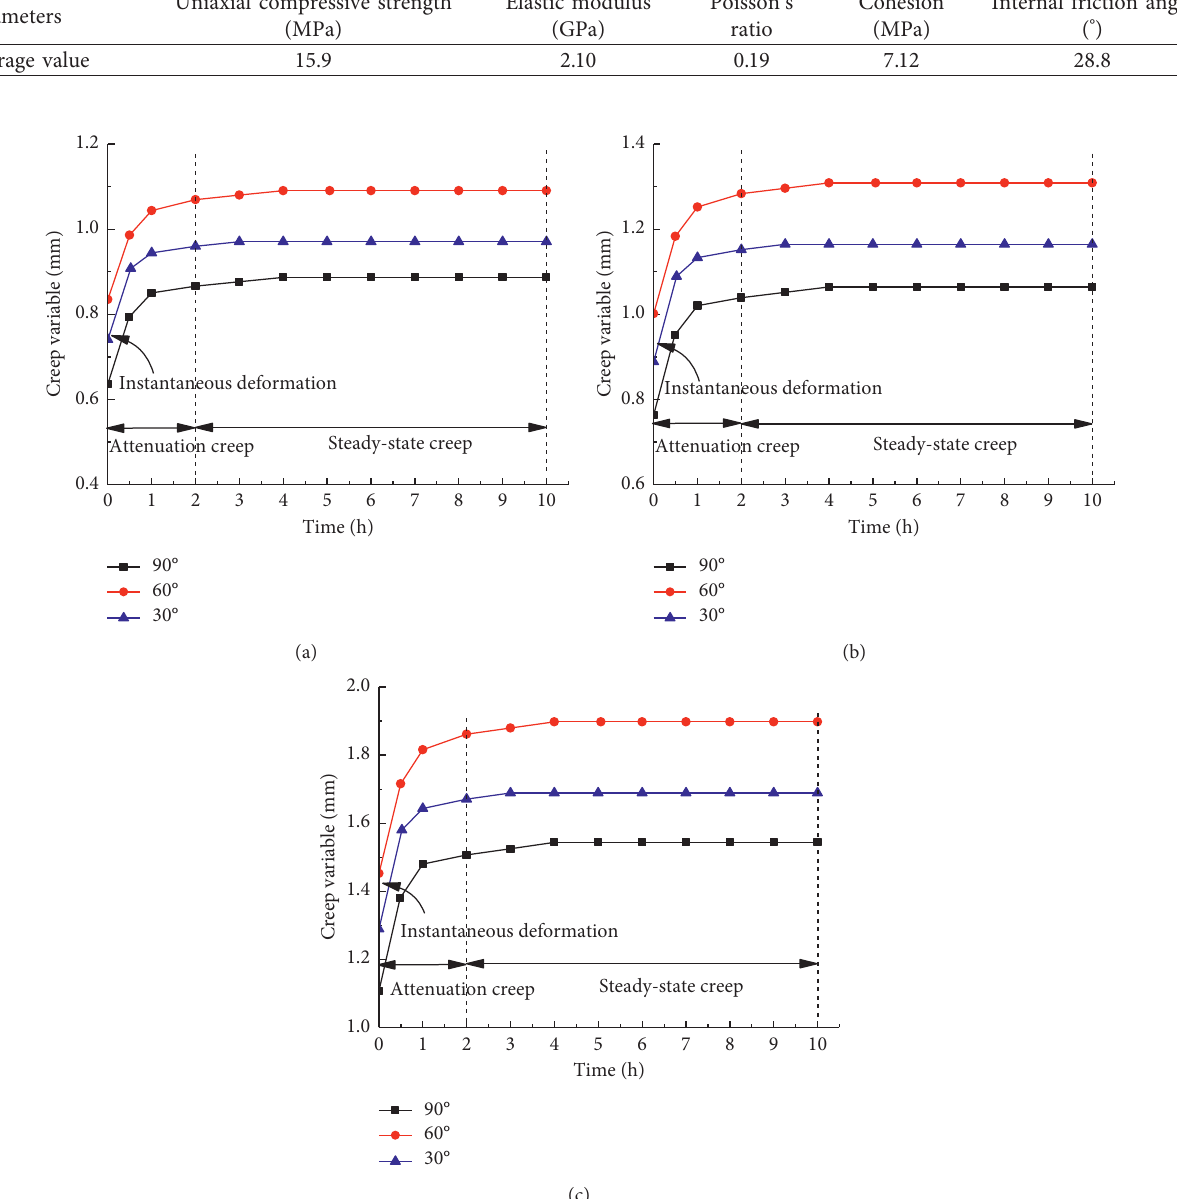
Figure 5: Longitudinal creep curve of anchored joint specimens. (a) The stress is 2MPa. (b) The stress is 4MPa. (c) The stress is